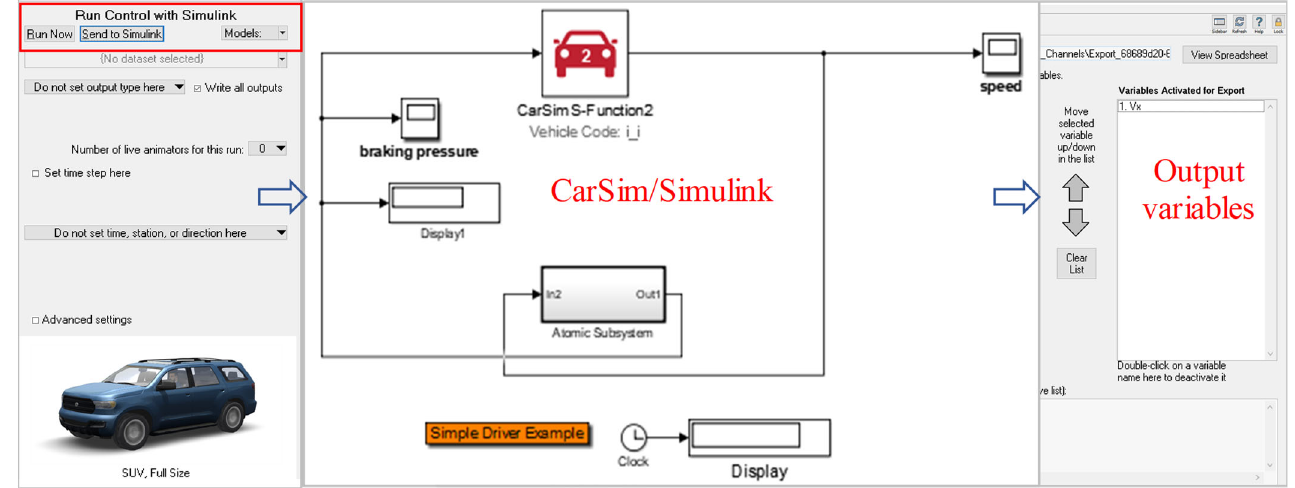
Figure 8. Calculation diagram of the CarSim/Simulink co ‐ simulation.